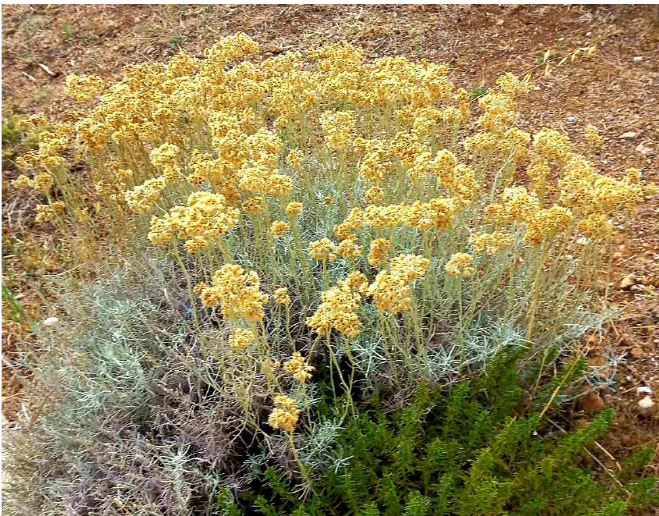
Figure 1. Helichrysum italicum in full blossom (photo taken by Dr. Veronika Furlan).